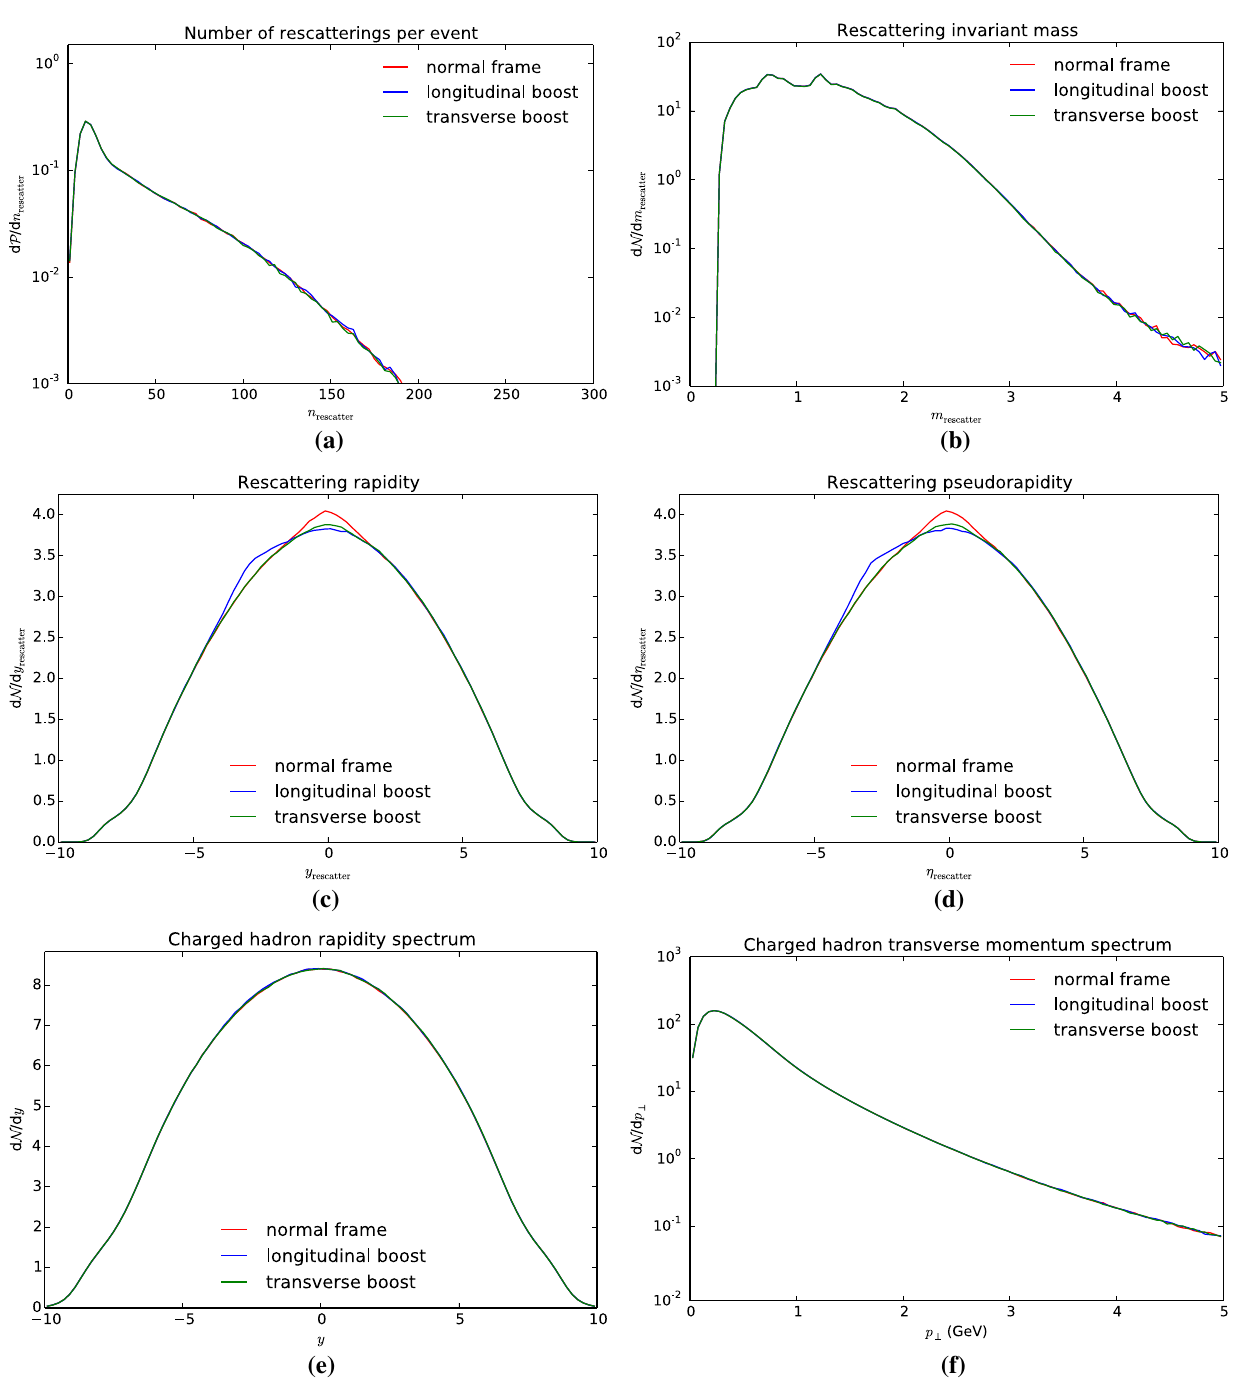
Fig. 11 Effects of modified time ordering on 13 TeV pp nondiffrac- tive collisions, where ordering is either in the normal rest frame, or in a frame boosted either longitudinally or transversely by three units of rapidity. a Number of rescatterings. b Invariant mass distribution of